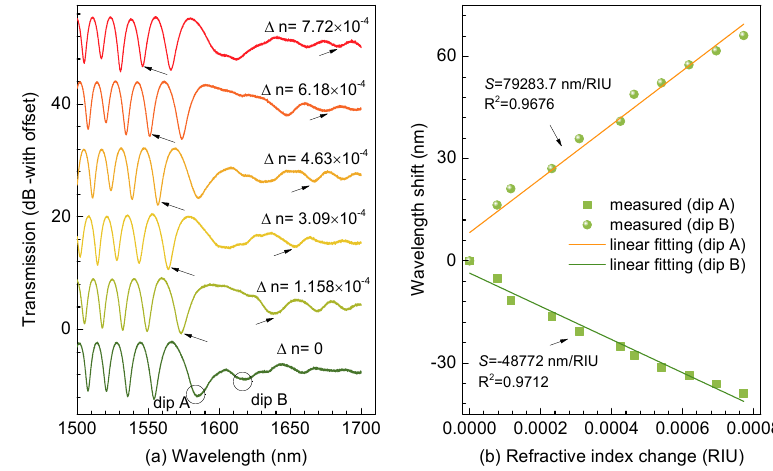
Figure 3. ( a ) Variation of interferential spectra as the ambient refractive index. ( b ) Wavelength shifts of Dips A and B versus ambient refractive index.